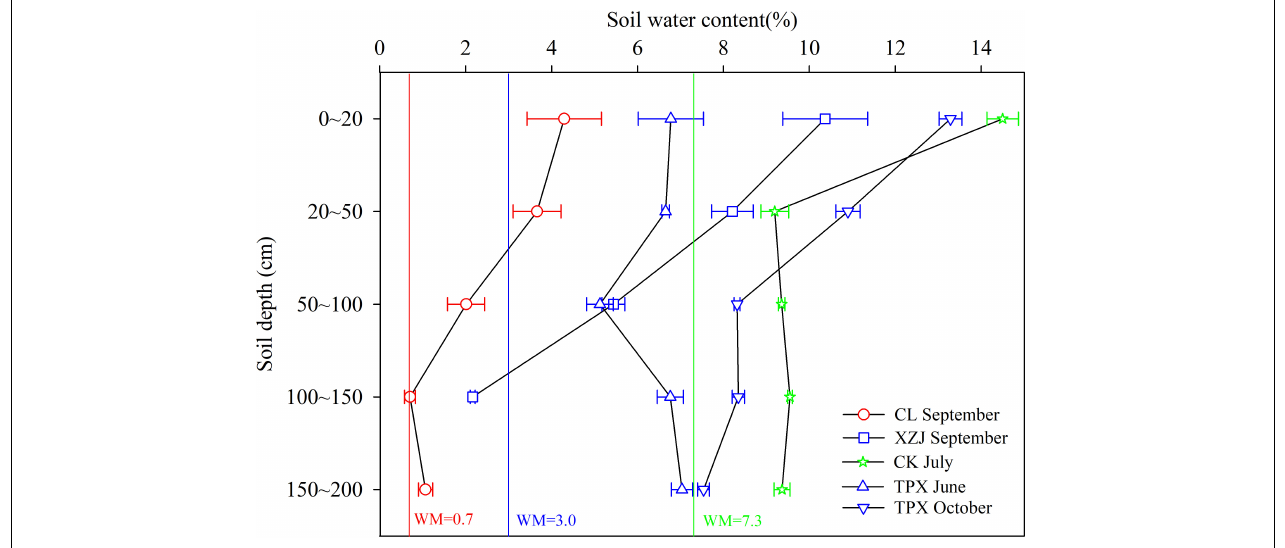
FIGURE 6 | Soil water content at different soil depths for each sampling site (The error bar indicates standard deviation; Red and Green lines show the wilting moisture for sites CL and CK, respectively; Blue line shows the wilting moisture for sites XZJ and